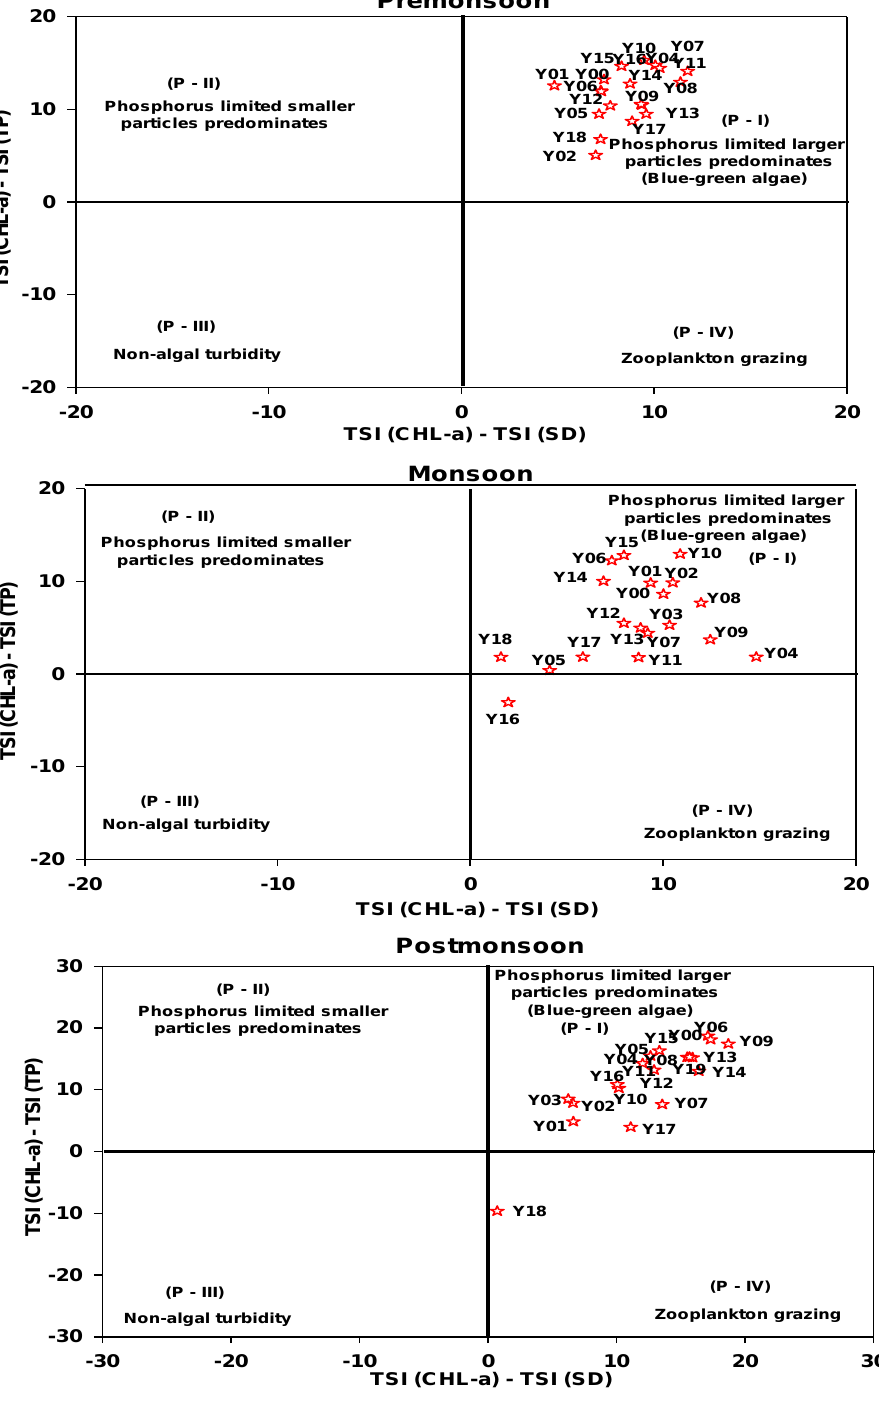
Figure 9. Trajectory analysis of trophic state index deviation during premonsoon (January–June), monsoon (July–August), and postmonsoon (September–December) seasons in the Daecheong Reservoir, based on the years 2000–2018.